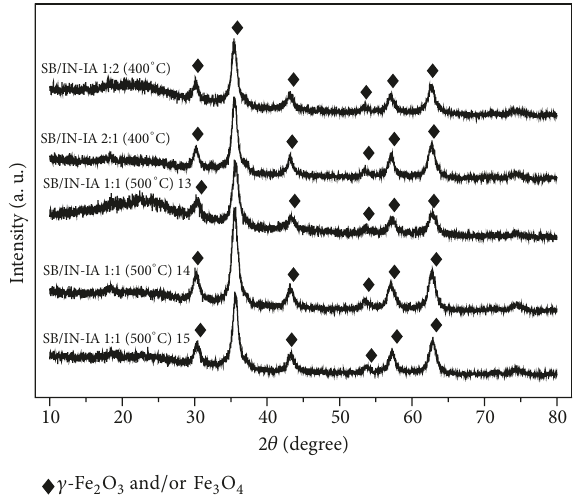
Figure 3: X-ray diffraction patterns of composites SB/IN-IA 1:2 (400 ∘ C), SB/IN-IA (400 ∘ C), SB/IN-IA 1:1 (500 ∘ C) 13, SB/IN-IA 1:1 (500 ∘ C) 14, and SB/IN-IA 1:1 (500 ∘ C)